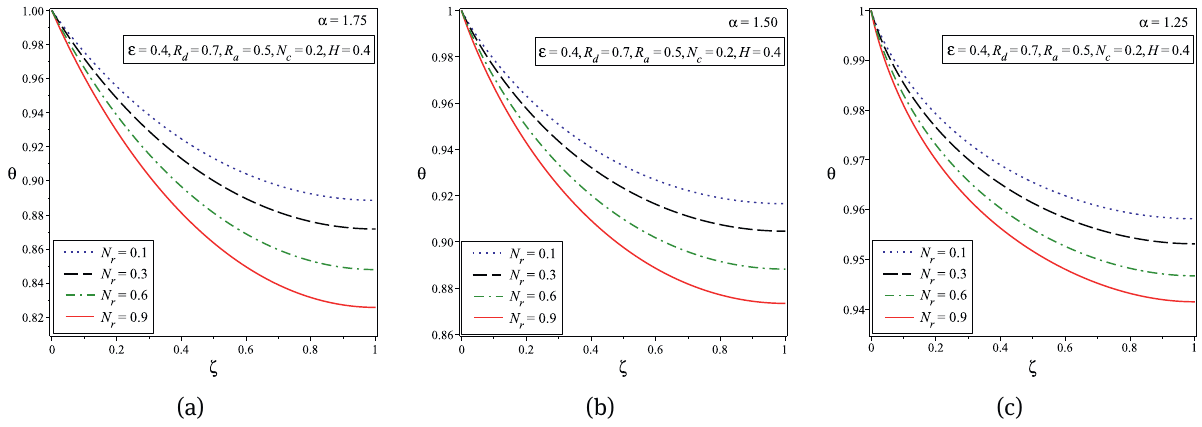
Fig. 3: The ADSTM solutions for a different value of N r and for (a) α = 1.75 (b) α = 1.5 (c) α = 1.25 .